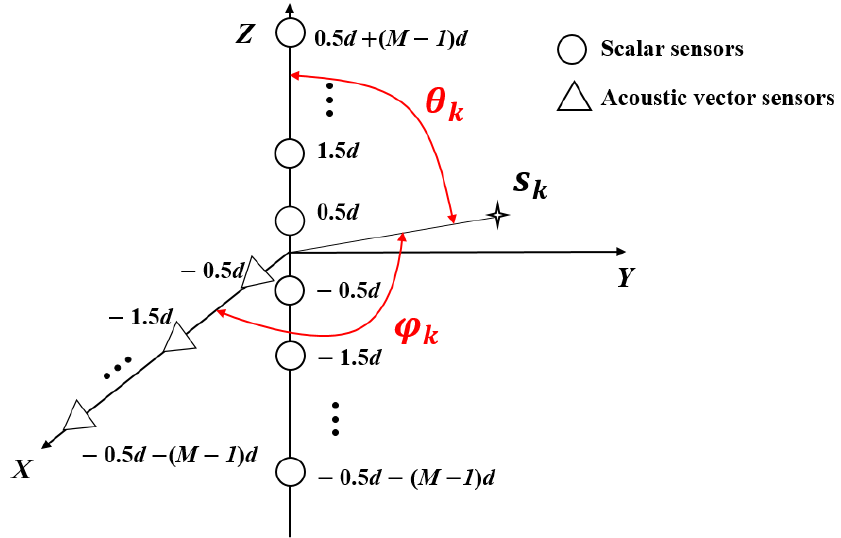
Figure 1. Proposed hybrid T-shaped sensor array con fi guration.